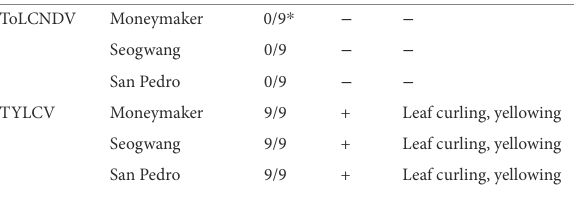
TABLE 2 Infectivity of single infections with ToLCNDV and TYLCV infectious clones on tomato. Infectious clone